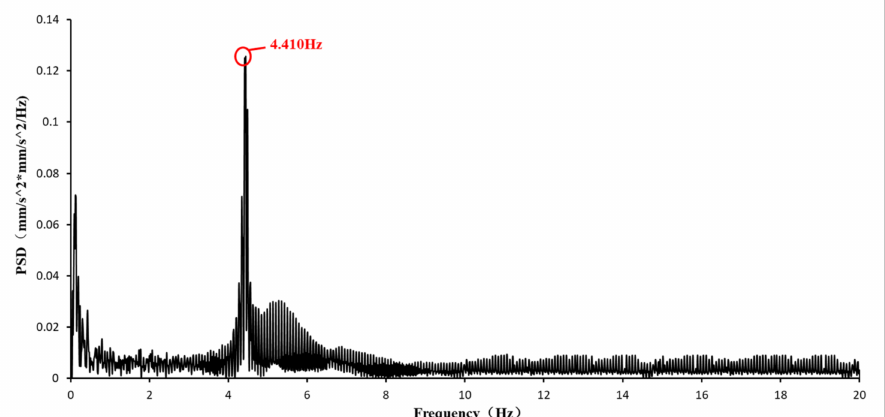
Figure 11. Modal parameter identification results of differential filtering of UAV signals.